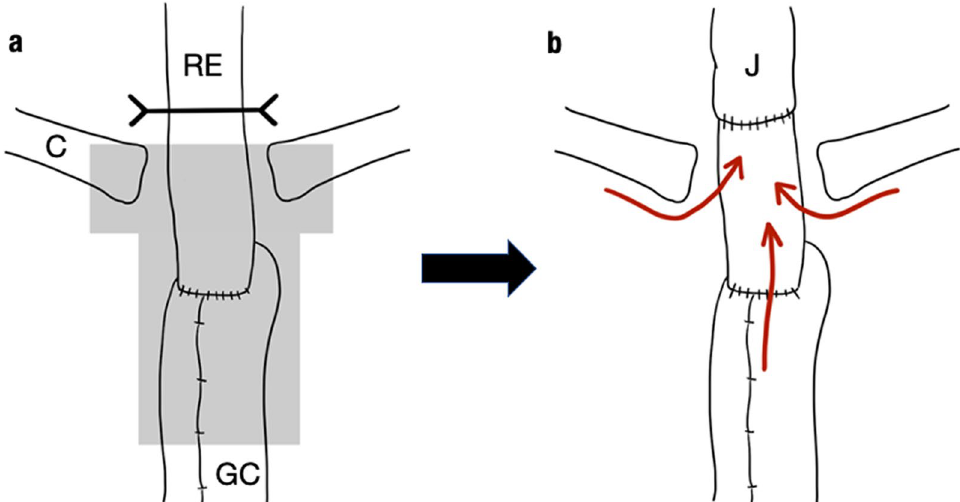
Fig. 2 Intraoperative schema. RE: remnant esophagus, GC: gastric conduit, C: clavicle, J: jejunum. a There was firm adhesion around the remnant esophagus and gastric conduit on the dorsal area of the sternum (gray area). Black line is the resected line. b Blood flow to the remnant esophagus was thought to be nourished through the anastomosis and surrounding tissues (red arrows)